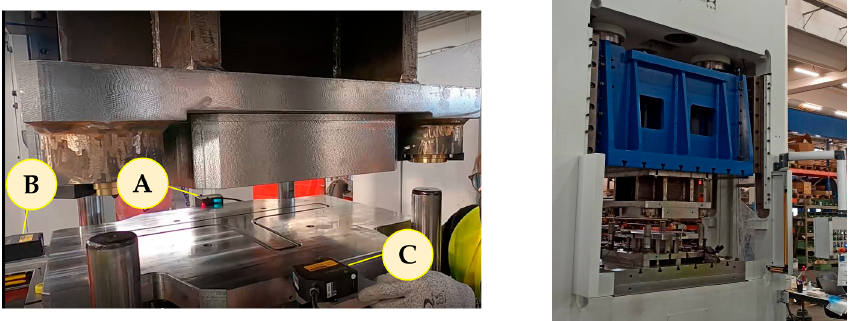
Figure 2. Hydraulic press machine adopted for experimental tests and laser triangulation sensors corresponding to the points (A, B and C) where the draw-in was monitored.